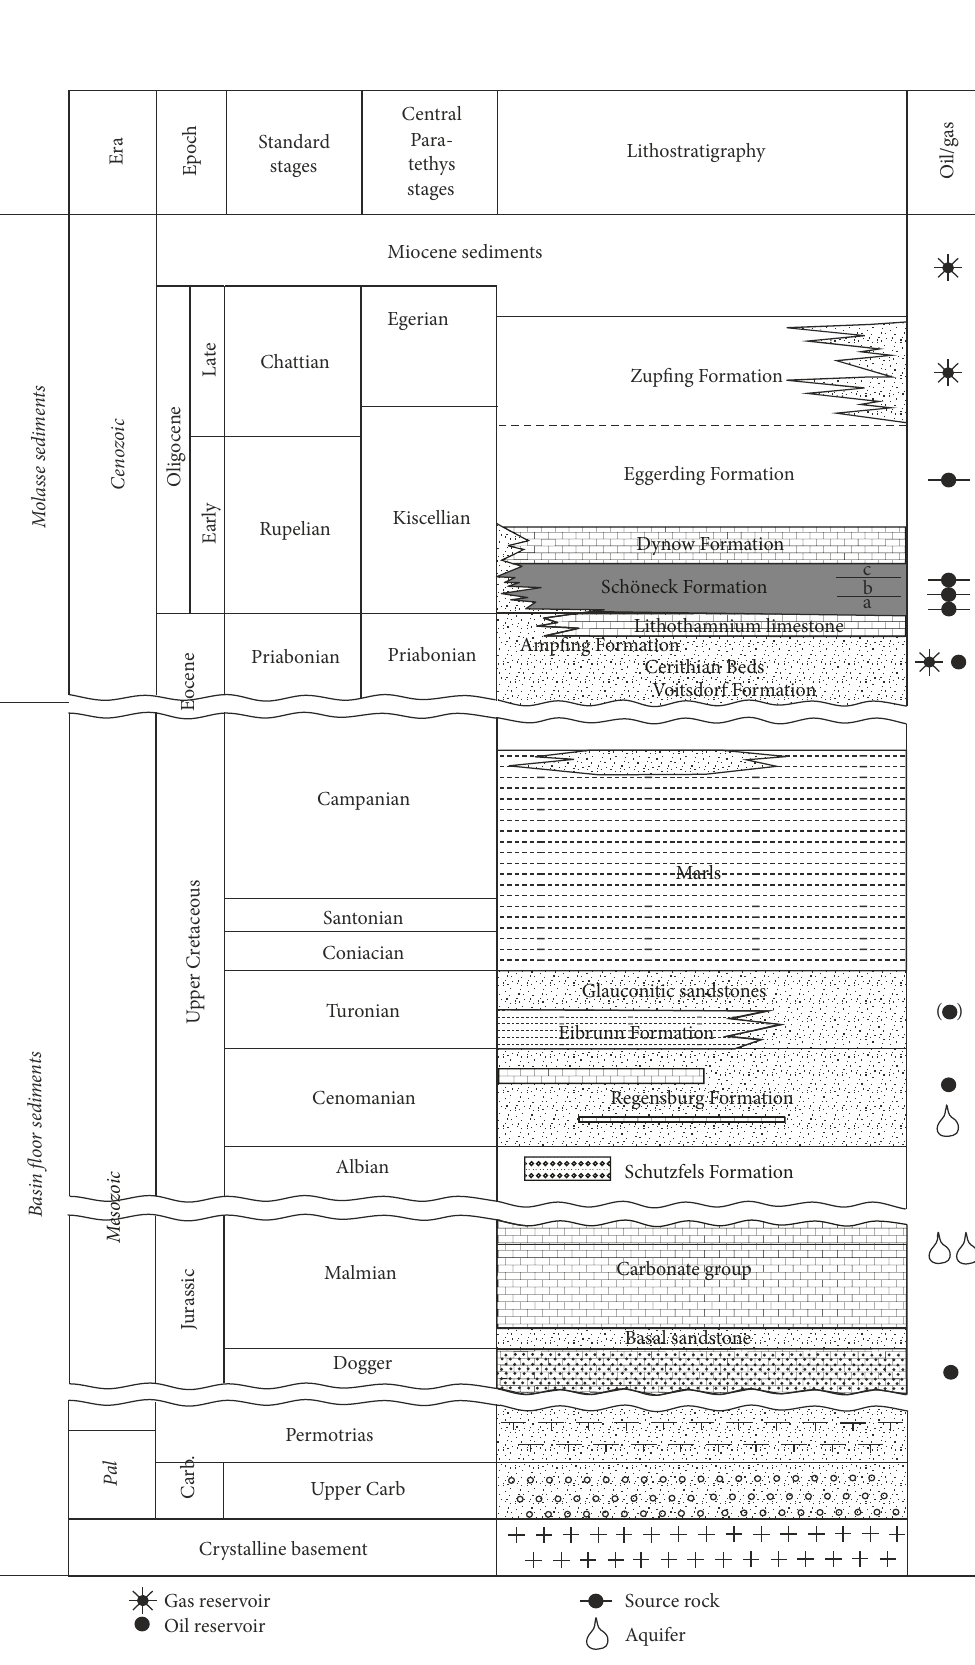
Figure 2: Time stratigraphic table of the Austrian part of the Alpine Foreland Basin; source rock and oil and gas occurrences are indicated (after